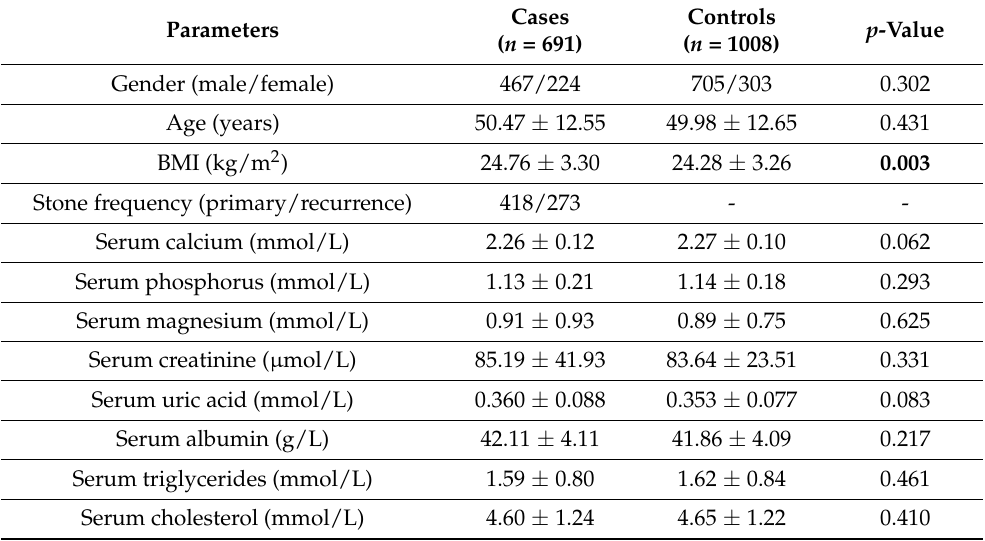
Table 1. Baseline characteristics of the study population. The bold means statistically significant difference. Parameters